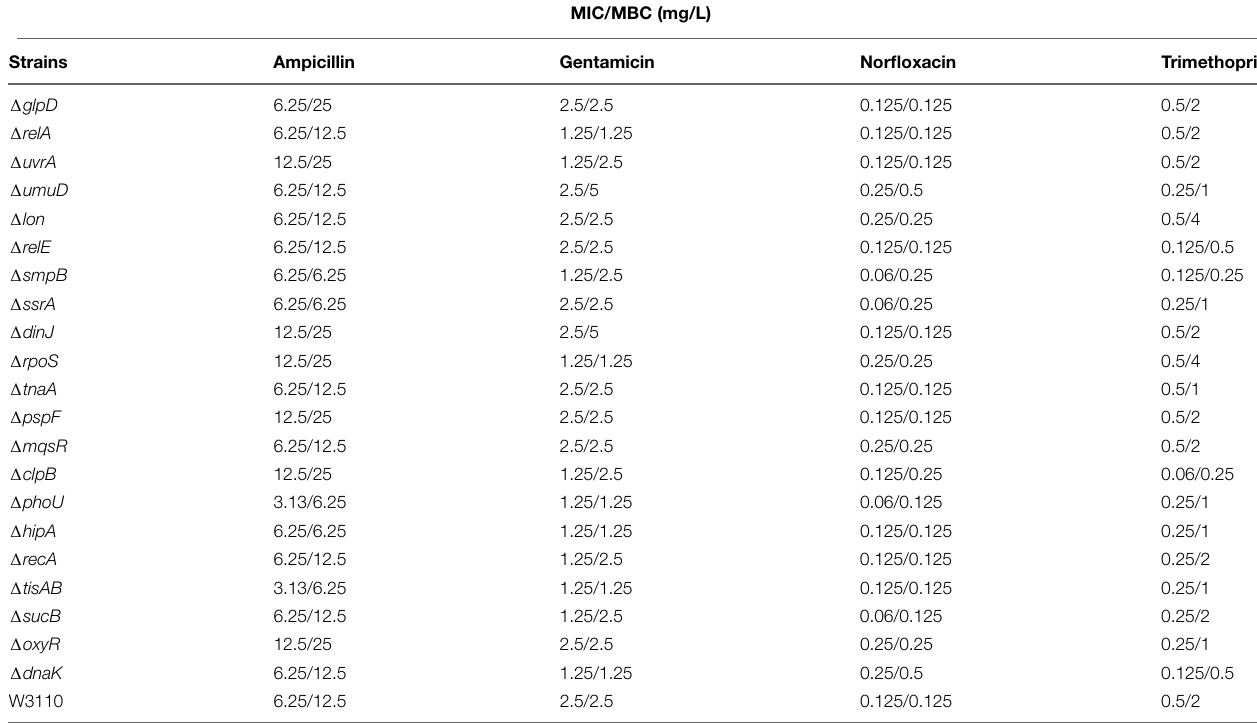
TABLE 2 | Minimum inhibitory concentration (MIC) and minimum bactericidal concentration (MBC) determination for 21 persister mutants and the parent strain E. coli W3110 using different antibiotics ∗